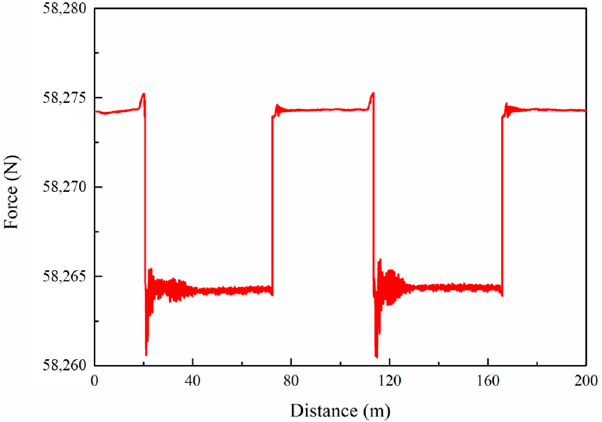
Figure 16. Changes in the Z-direction component force of the hydraulic cylinder during the operation.